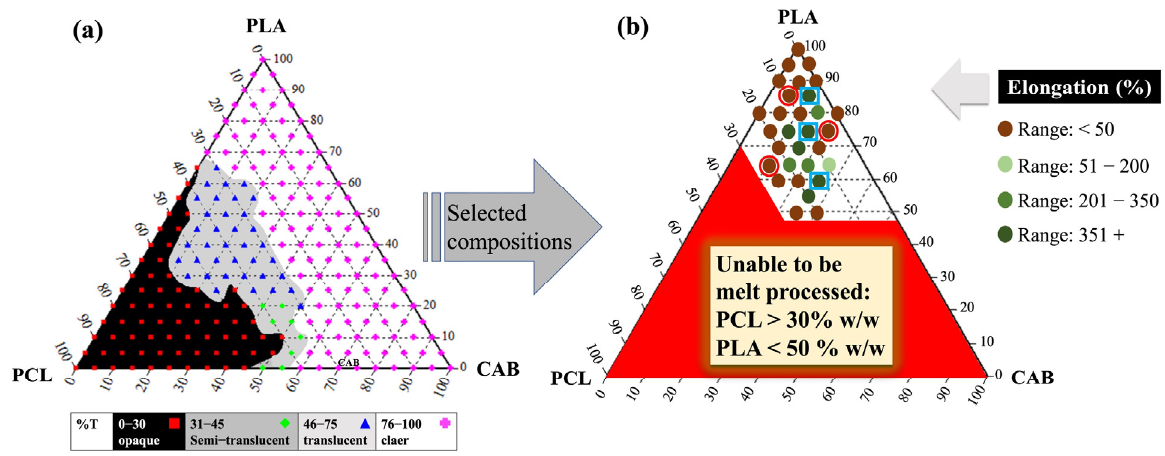
Figure 1. The optical ternary phase diagram of solvent-mediated blends of PLA/PCL/CAB con- structed by the rapid scanning method ( a ), and the compositions that were able to be melt-blown into films with having different percentage of elongation at break ( b ). NB: Samples of HE (blue squares) and LE (red circles) were chosen to study further.